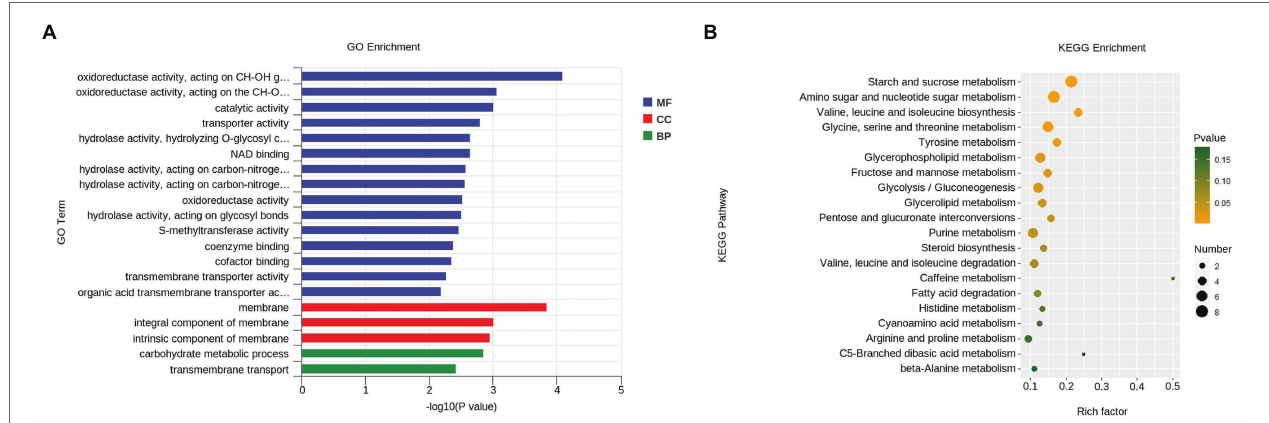
FIGURE 4 | Functional enrichment analyses for DEGs in P. penicillatus during the infection process. (A) GO enrichment analyses. GO term enrichment values of p are indicated on the x -axis. BP, biological process; MF, molecular function; CC, cellular component. (B) KEGG enrichment analyses. The x -axis represents the rich factor. The size of the dot indicates the number of DEGs involved in the pathway. Color bars on the right represent the value of p of the KEGG pathway. DEGs, differentially expressed genes; GO, gene ontology; KEGG, kyoto encyclopedia of genes and